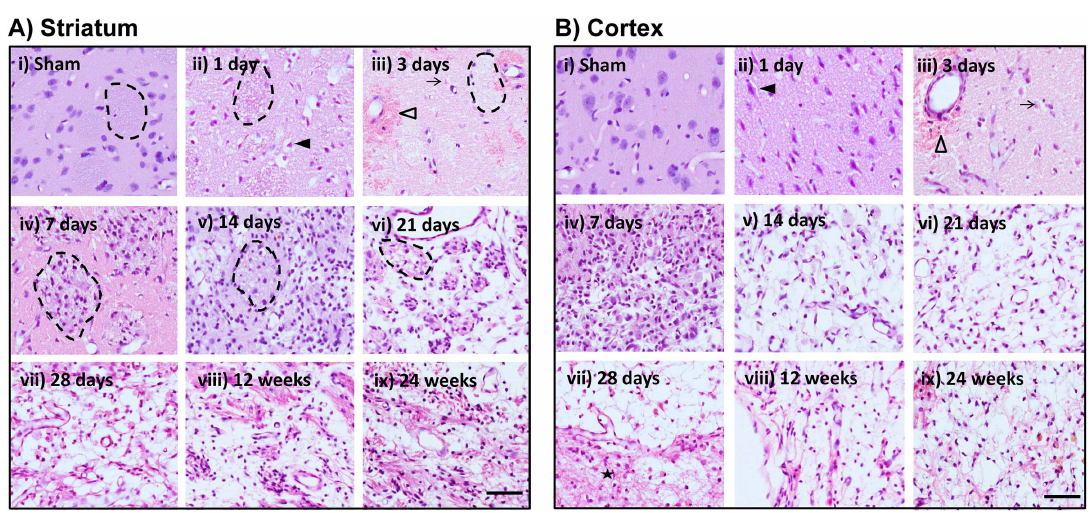
Fig 3. Evolution of ischemic related damage resulting from MCAo. Representative images taken through the centre of the area of damageat approximately 1.7mm relative to bregma. A) Striatum. B) Cortex. Scale bar represents50 μ m. Filled arrow head = red neuron; Open arrow head = hemorrhagictransformation; Arrow = Ghost neuron; Dotted line = striatal bundle; Star = Glial scar.